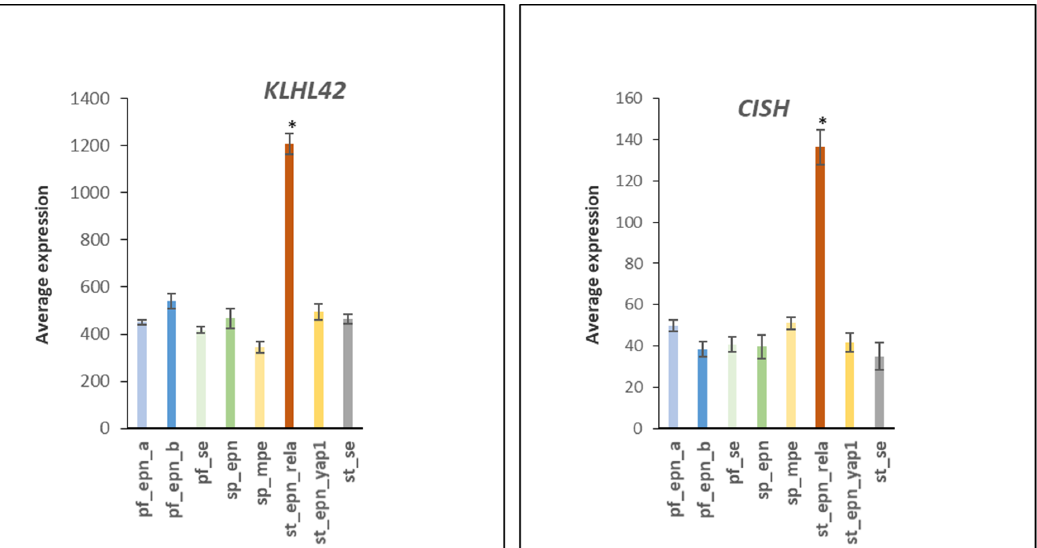
Figure 18. Elevated gene expression of KLHL42 and CISH in ST_EPN_RELA (by Anova, F = 84.68, p = 1.75 × 10 − 56 ; F = 39.09, p = 2.55 × 10 − 34 , respectively). * significantly different from all other groups by t -test p < 0.001. Dataset GSE64415.